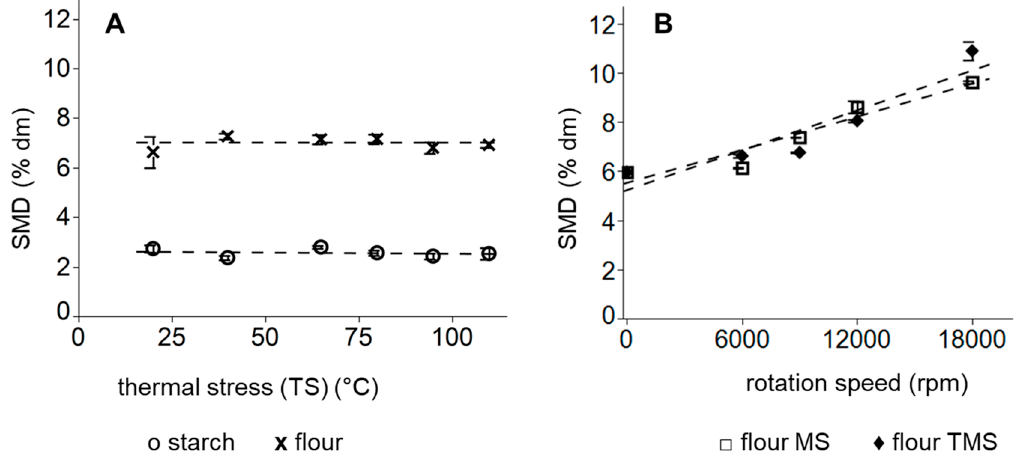
Figure 4. Mean starch modification degree after ( A ) exclusively thermal treatment of flour x and starch Ο and ( B ) after mechanical treatment with thermal stress (TMS) ♦ or without thermal stress (MS) ≤ of wheat flours. Error bars represent standard deviations; n = 3.